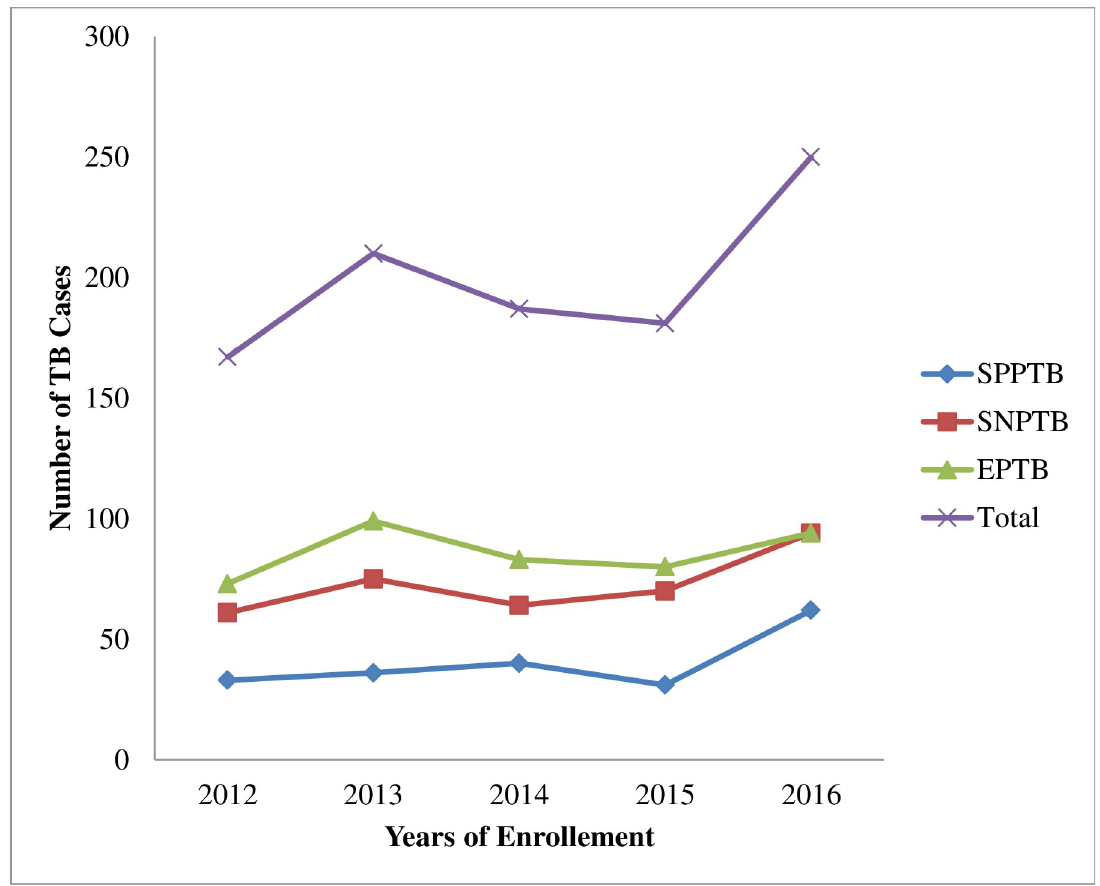
Fig 2. Trends of TB at three TB treatment centers in East Wollega from 2012 to 2016. SPPTB,sputum positive pulmonary tuberculosis; SNPTB,sputum negative pulmonary tuberculosis; EPTB,extrapulmonary tuberculosis.